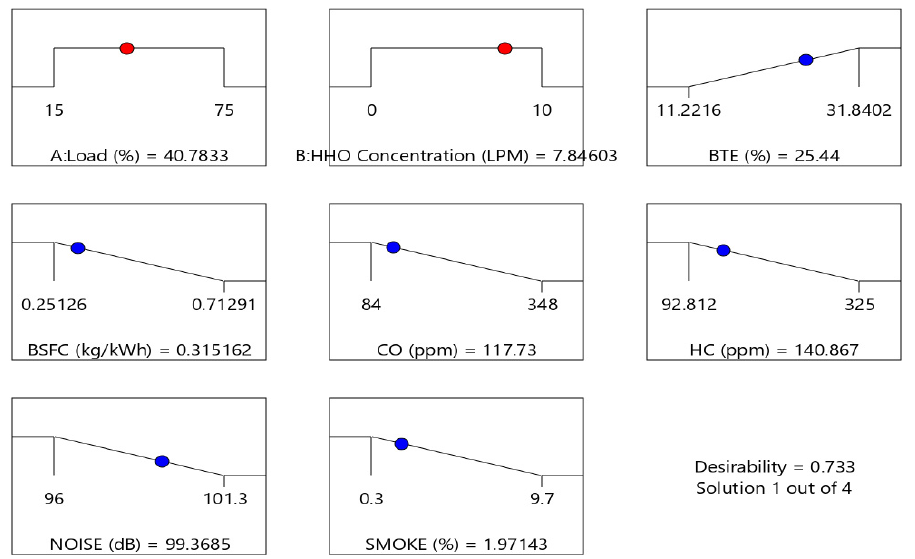
Figure 14. Design expert identified optimum points. The statistical identification of how optimization involved the overall responses could be studied through composite desirability (D). It is a unitless value in the range of 0–1, with 1 for the best and 0 for the worst case. In the current study, composite desirability is 0.733, which is a clear indication that the optimization settings have achieved favorable outcomes for all responses. The contour plot of desirability is shown in Figure 15. Moreover, the impact of individual responses on the overall setting could be assessed through the individual desirability (d) of each response, as shown by the bar graph in Figure 16. It is evident that d is largest for CO (0.877) and lowest for noise (0.364). The numerical values show that minimizing carbon monoxide emissions would have the greatest impact on the overall settings compared, and minimizing noise would impart the least impact to the setting as a